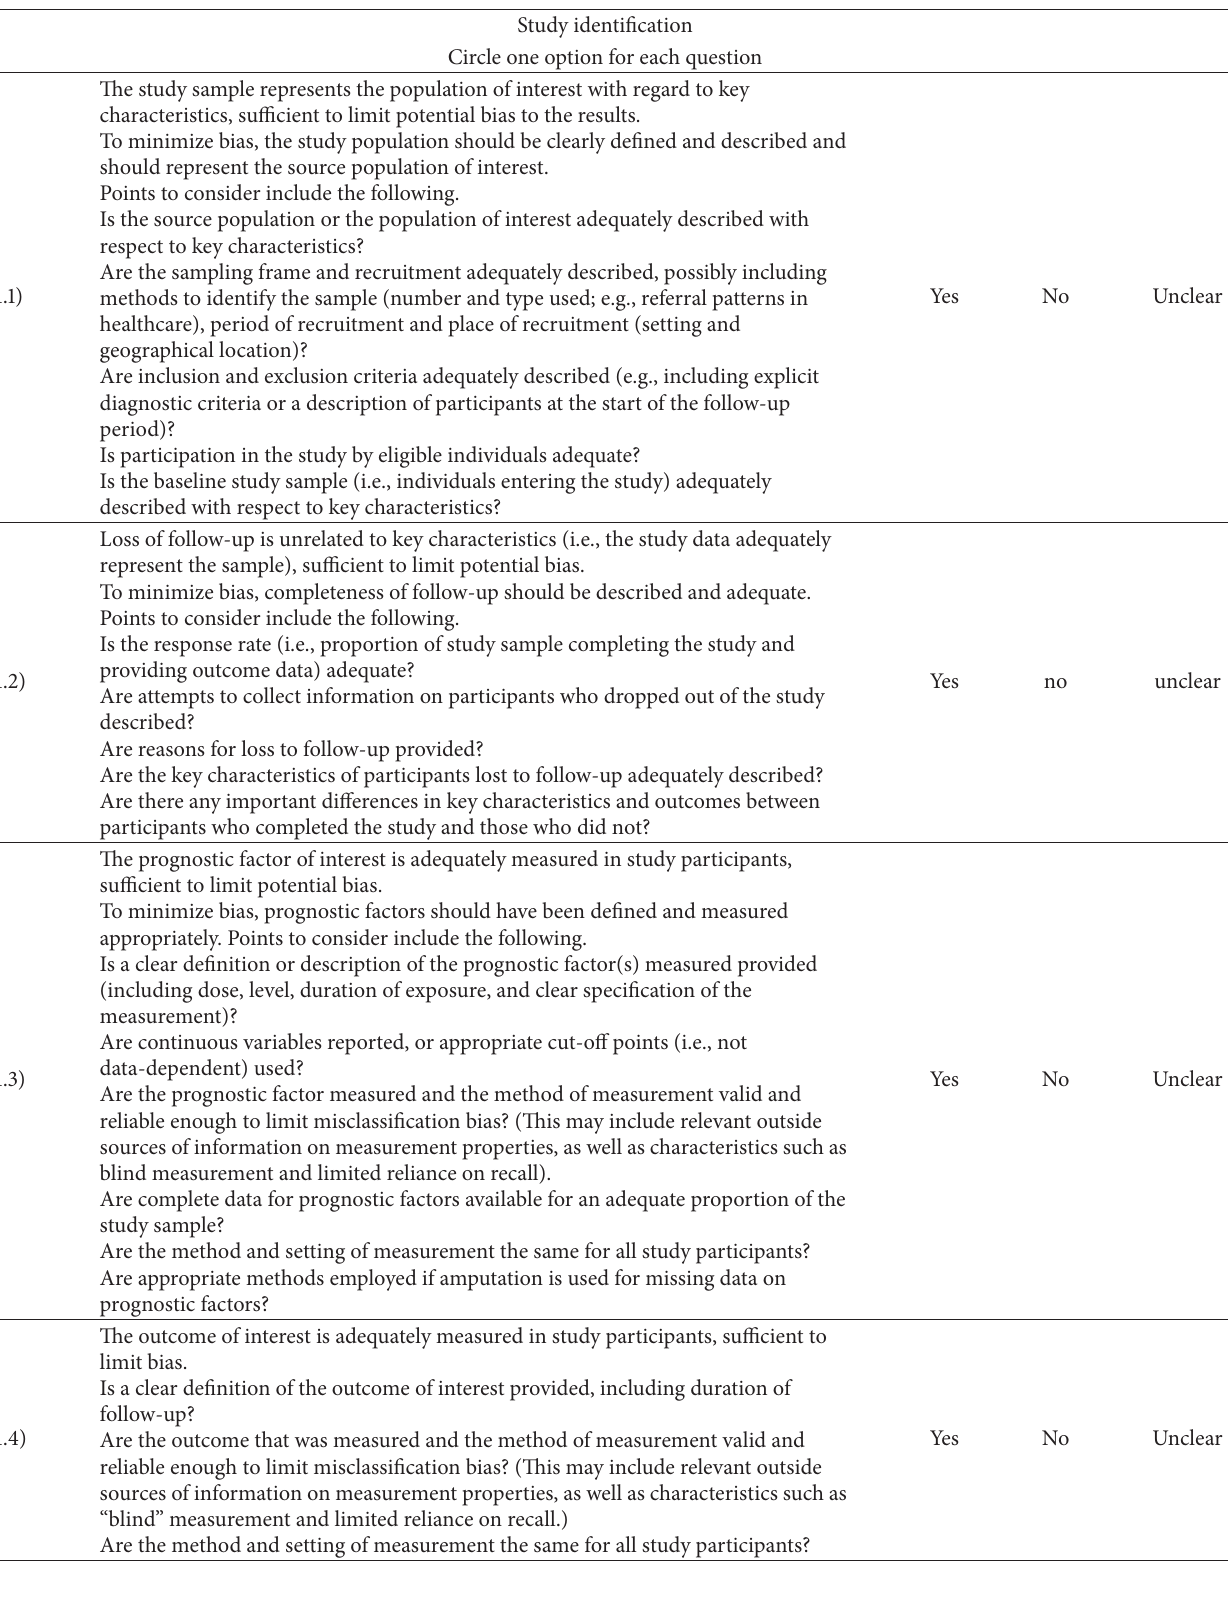
Table 2: Methodological checklist for prognostic studies developed by the National Institute for Health and Clinical Excellence from United Kingdom